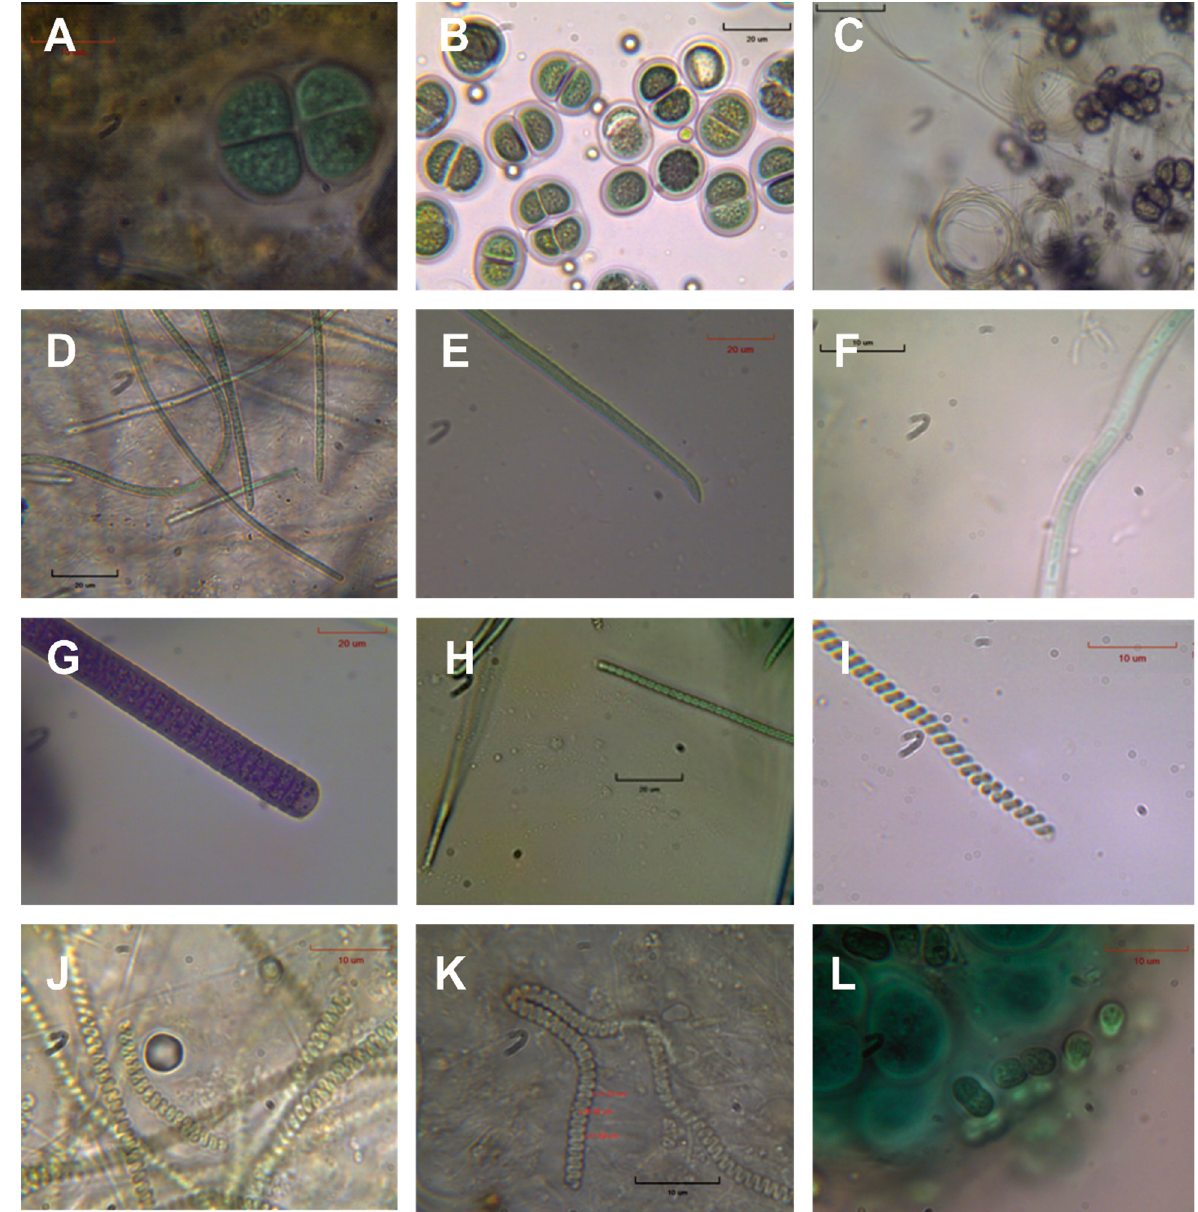
Figure 6. Cyanobacterial microflora under an optical microscope. ( A ) Chroococcus minutus (Scale bar: 10 μ m), ( B ) Chroococcus turgidus (Scale bar: 20 μ m), ( C ) Johannesbaptistia pellucida (Scale bar: 50 μ m), ( D ) Kamptonema chlorinum (Scale bar: 20 μ m), ( E ) Kamptonema formosum (Scale bar: 20 μ m), ( F ) Leptolyngbya perforans (Scale bar: 10 μ m), ( G ) Oscillatoria crassa (Scale bar: 20 μ m), ( H ) Pseudanabaena minima (Scale bar: 20 μ m), ( I ) Spirulina cf. labyrinthiformis (Scale bar: 10 μ m), ( J ) Spirulina subtilissima (Scale bar: 10 μ m), ( K ) Spirulina tenuior (Scale bar: 10 μ m), ( L ) Synechocystis salina (Scale bar: 10 μ m).